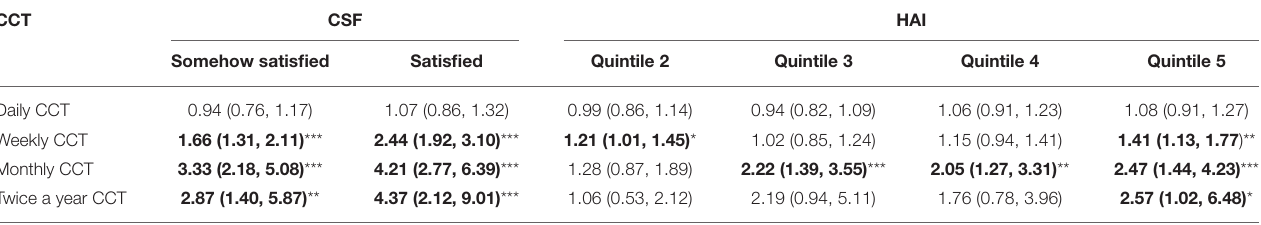
TABLE 2 | Multinomial logistic regression analysis for CCT associated with satisfaction and healthy aging in parents aged 45 and older, [relative risk ratio (RRR) (95% CI